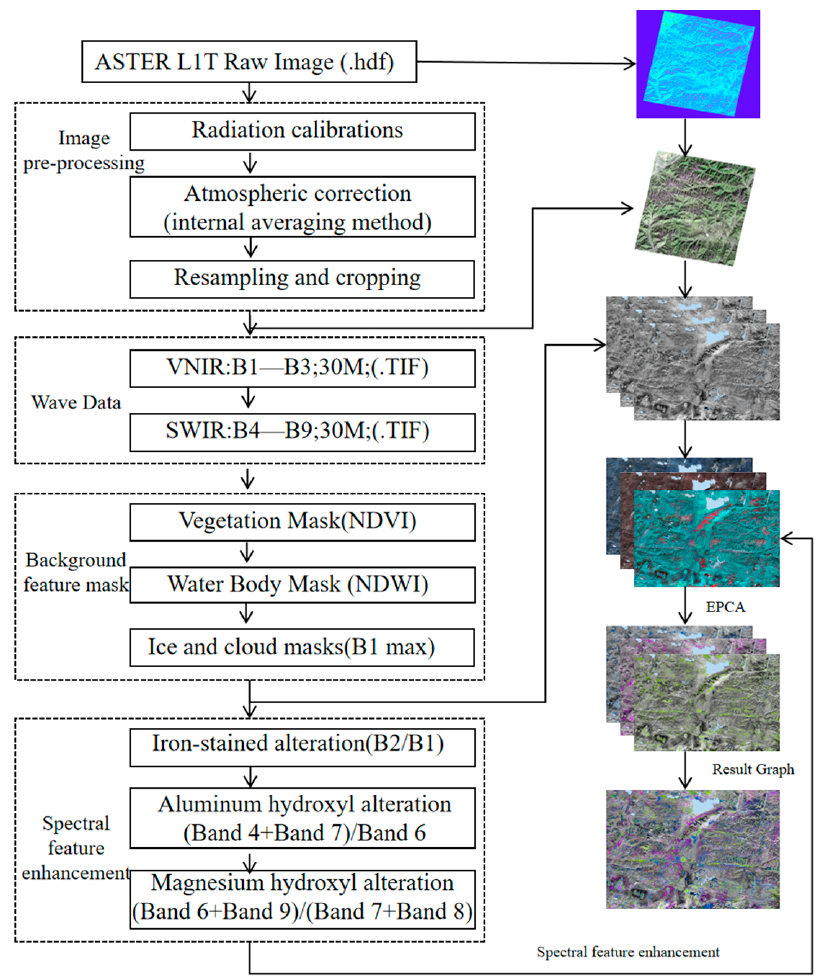
Figure 3. ASTER data pre-processing and spectral feature enhancement methodological flow chart.